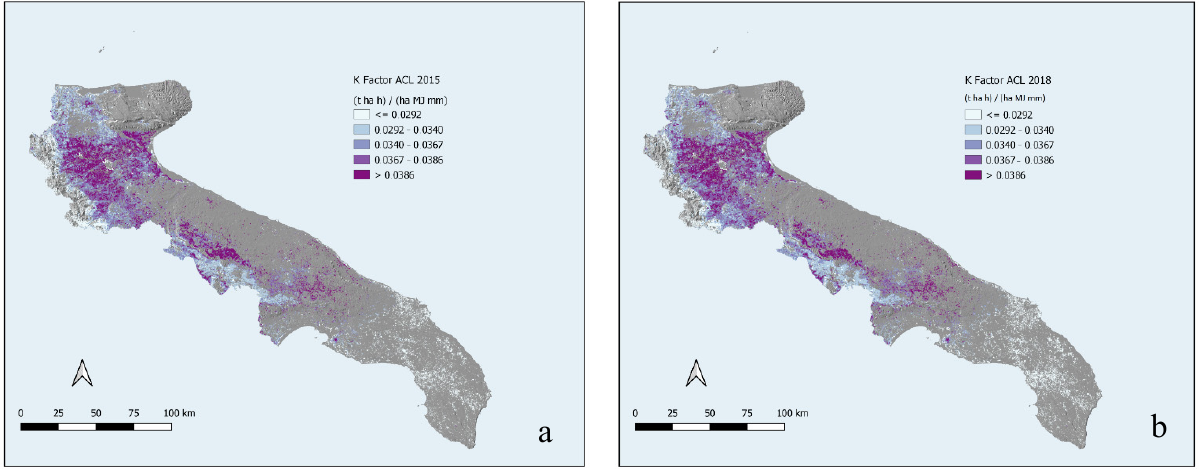
Figure 6. Soil erodibility factor ( K ) maps of the Apulia region for annual cropland in ( a ) 2015 and ( b ) 2018.